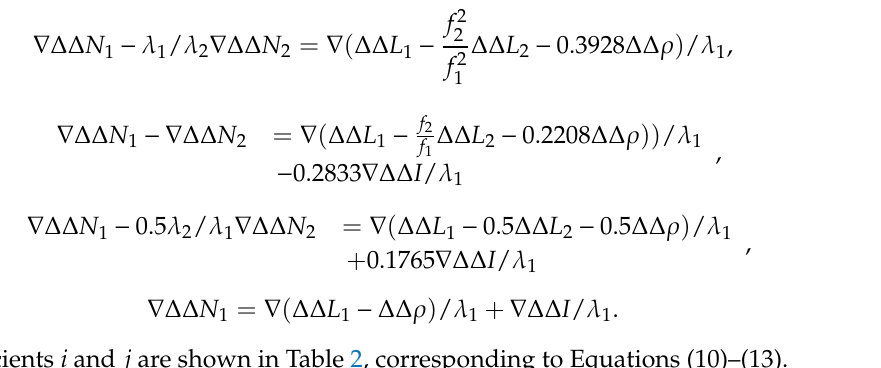
Table 2. Ionospheric and geometric distance residuals with the di ff erent coe ffi cients i and j . Equations i j 1 + α j